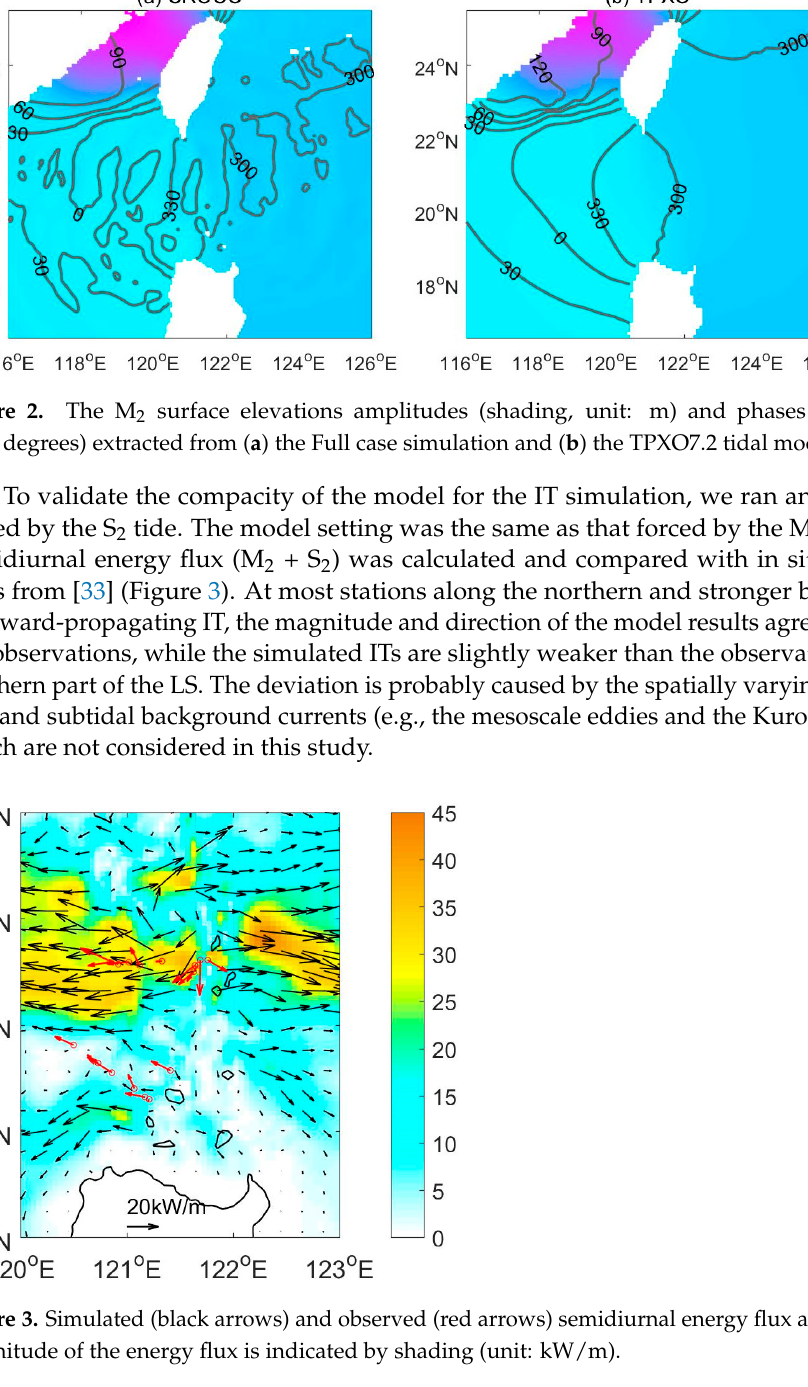
Figure 3. Simulated (black arrows) and observed (red arrows) semidiurnal energy flux at the LS. The magnitude of the energy flux is indicated by shading (unit: kW/m).